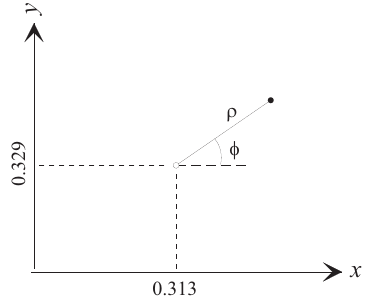
Figure 3. Evaluation of colour diversity. ρ : distance. φ ; direc- tion. ◦ denotes white point for D65.